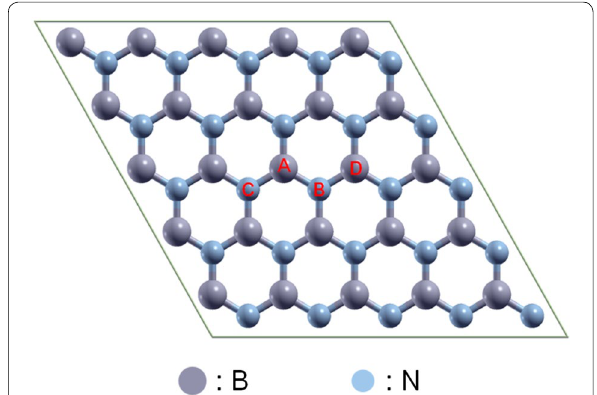
Fig. 1 Schematic illustration of multi‑vacancy creation on the 5 monolayer h‑BN supercell with 50 atoms. A , B , C , and D present a vacancy site corresponding to mono‑(1V B and 1V N ), di‑(2V BN ), and tri‑(3V 2NB and 3V 2BN )